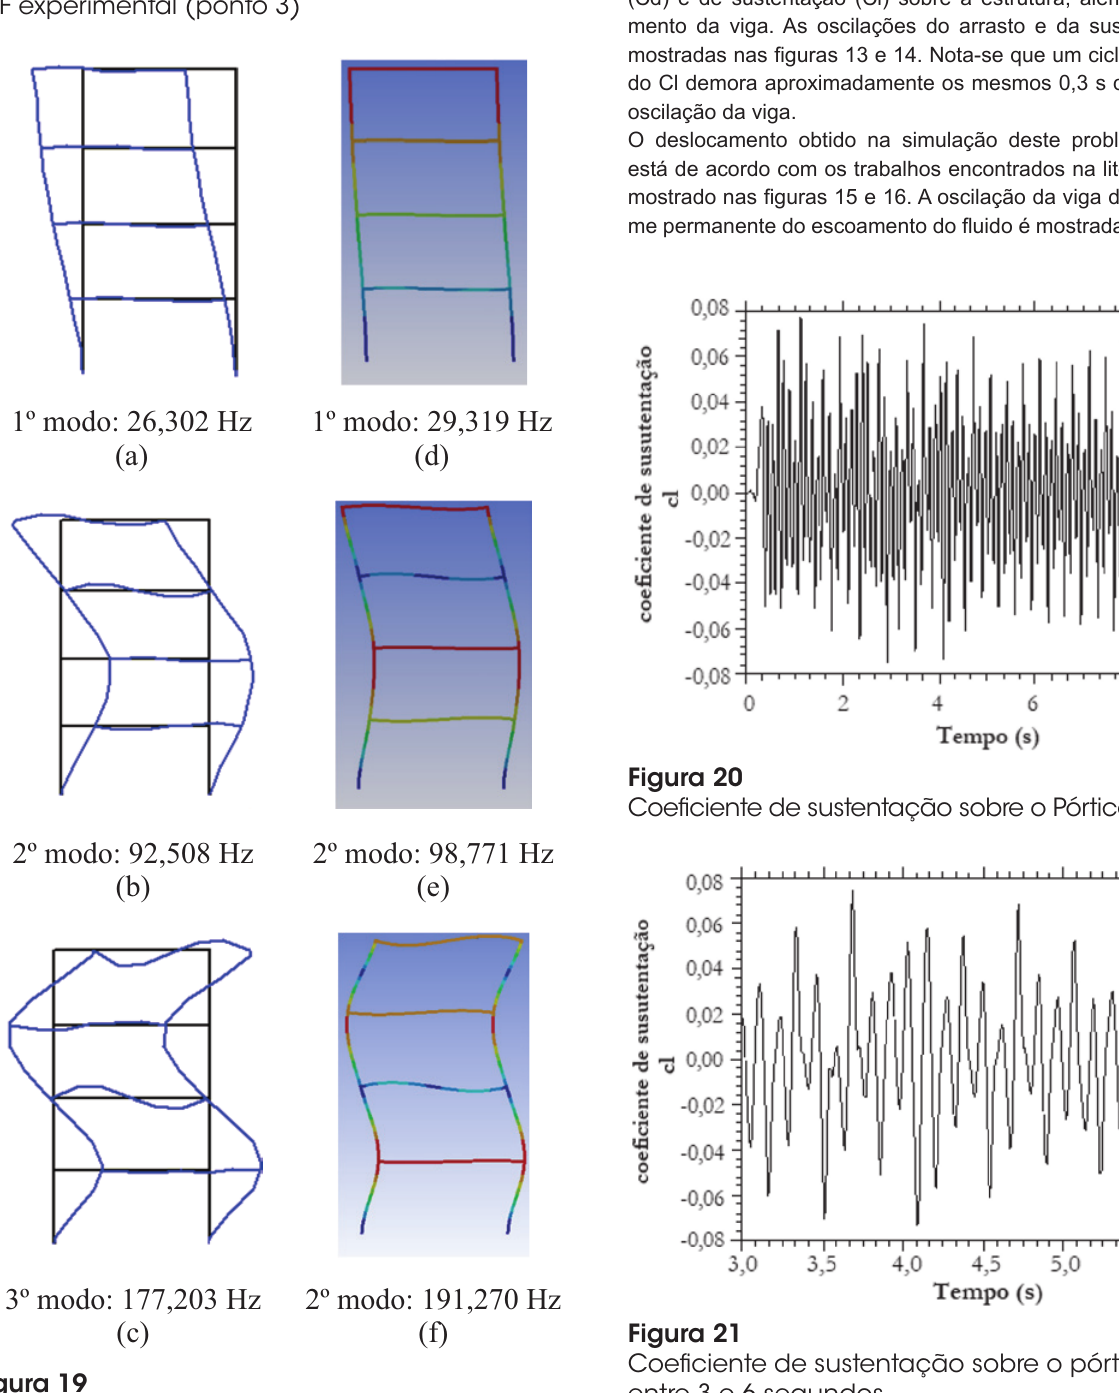
FRF experimental (ponto 3)